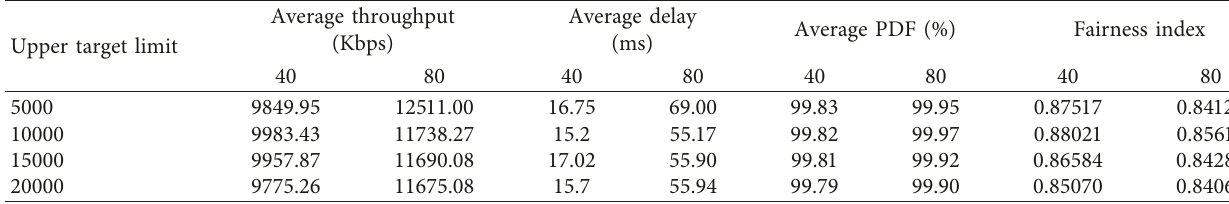
Table 4: Performance of the system for varying upper target limit of cwnd.